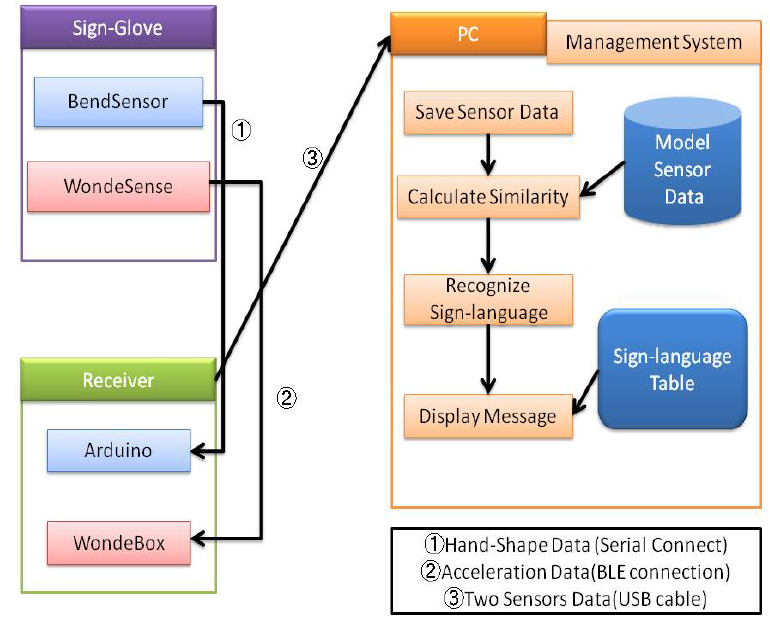
Figure 5. Architecture of the system.